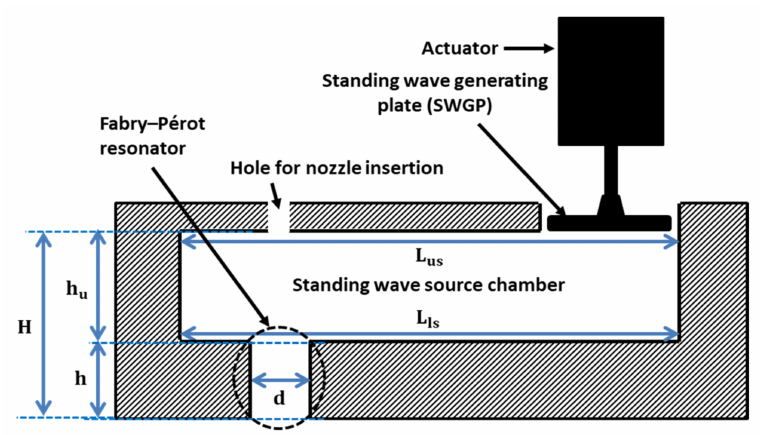
Figure 1. Schematic cross-sectional representation of SWAM, in which, L us and L ls represents the upper and lower surface lengths of the standing wave-source chamber, respectively, h u and h represents the heights of standing wave-source chamber and FP resonator, respectively, and H represents the height of both the standing wave-source chamber and FP resonator.